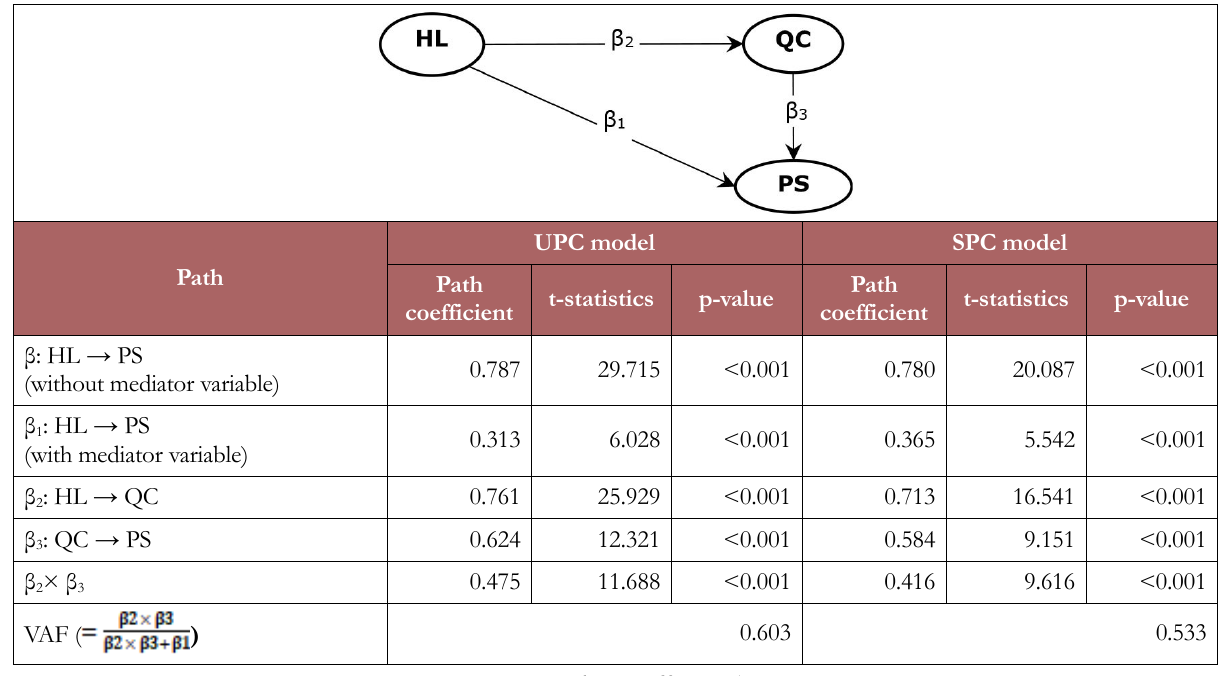
Figure 5. Mediating effect